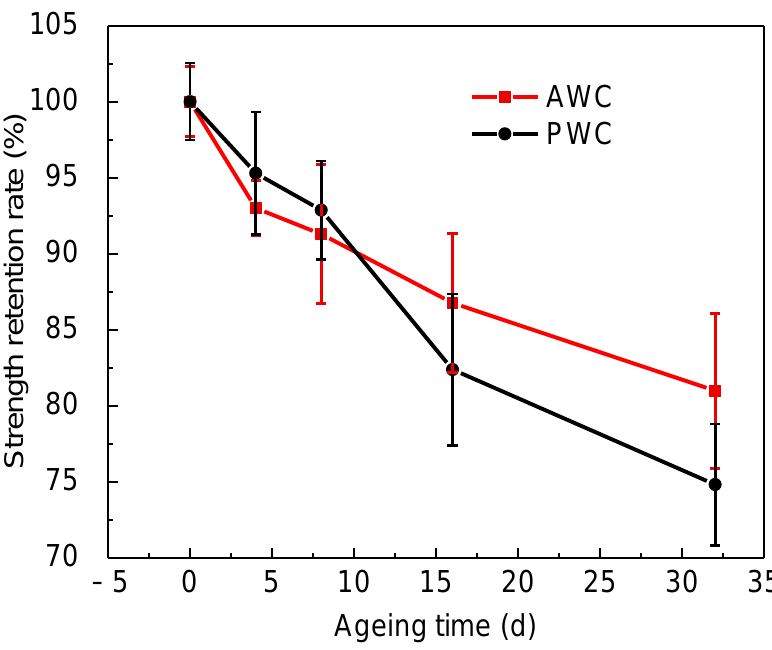
Figure 16. Retention rate of the short beam strength along with ageing time. The obvious decline could be attributed to the change of failure modes after long-term exposure, as depicted in Figure 17.